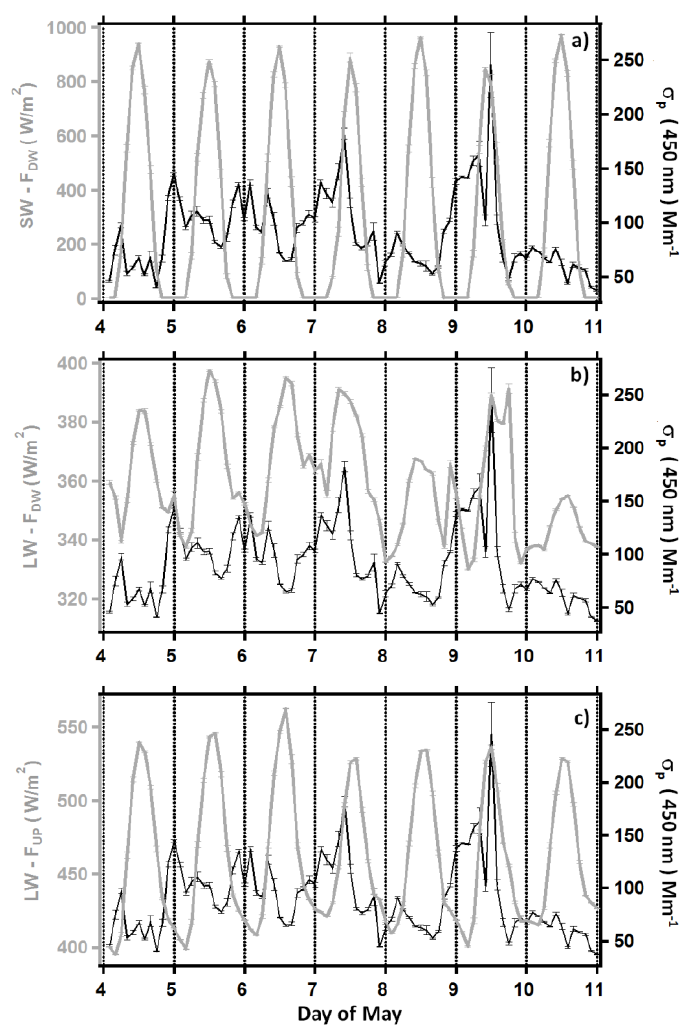
Figure 6. Comparison of the time evolution of the two hour-averaged σ p (black line) with one of ( a ) SW-F DW (grey line), ( b ) LW-F DW (grey line), and ( c ) LW-F UP (grey line), from 4 to 10 May 2015. The error bars represent the corresponding SEMs.